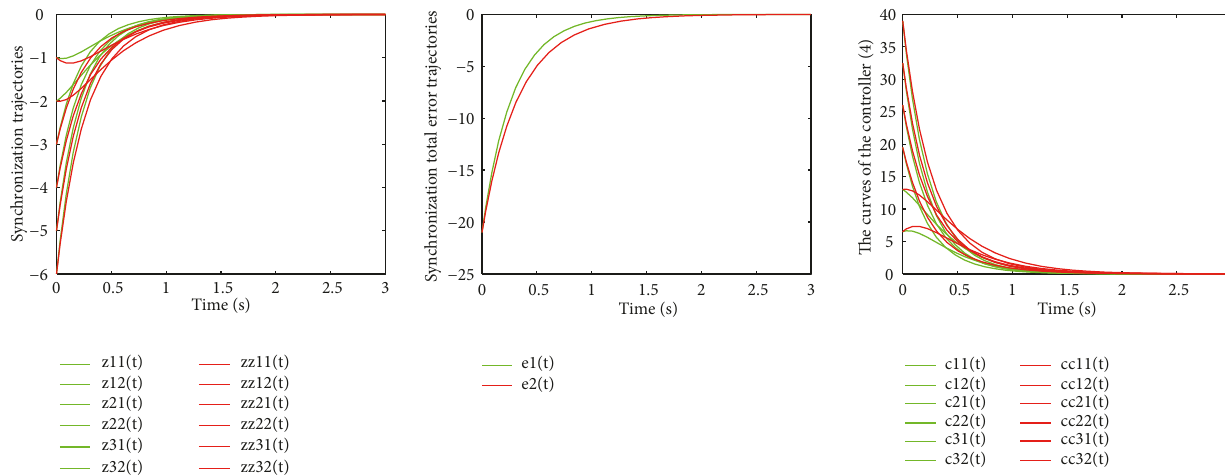
Figure 7: Synchronization trajectories, synchronization total error trajectories of networks (1) and (2) with controller (4) and the curves of controller (4) for Case I-3 of Example